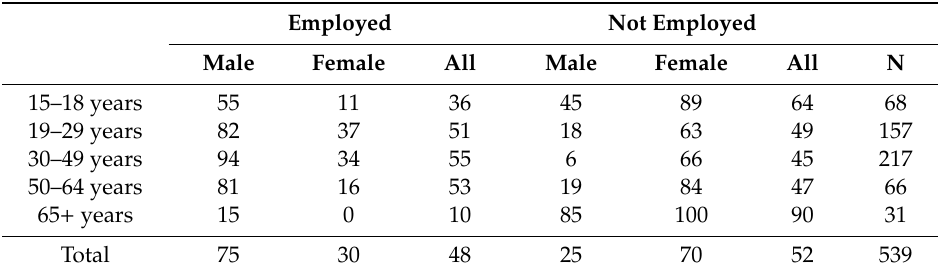
Table 2. Afghan refugee respondents’ employment in the GTs in Iran (%). Employed Not